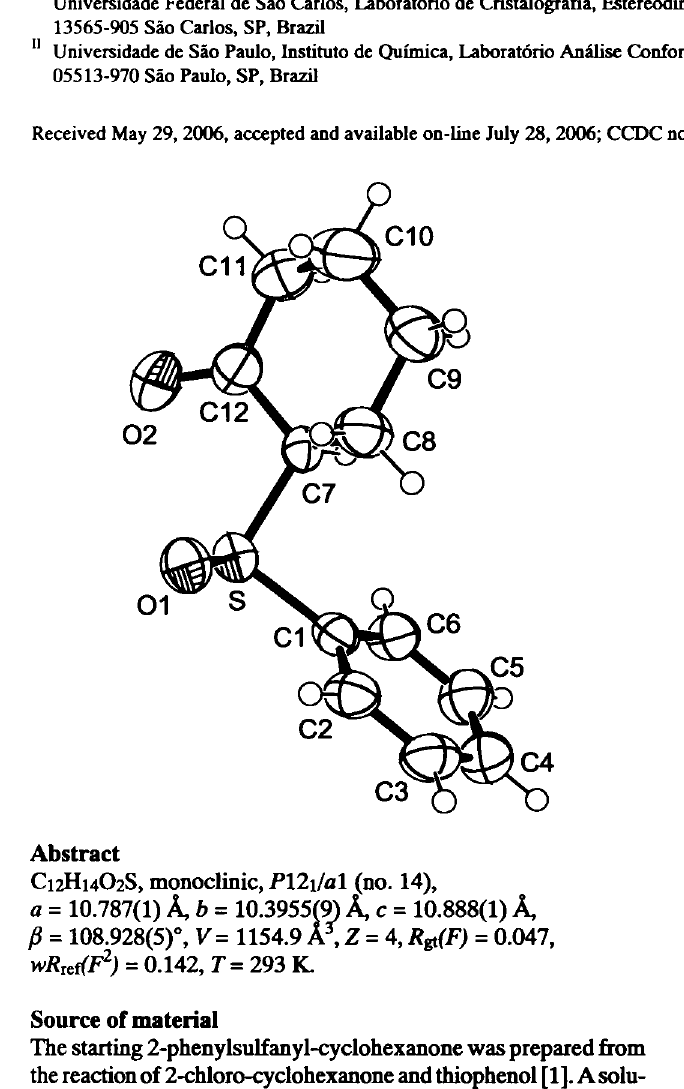
Table 2. Atomic coordinates and displacement parameters (in Ä 2